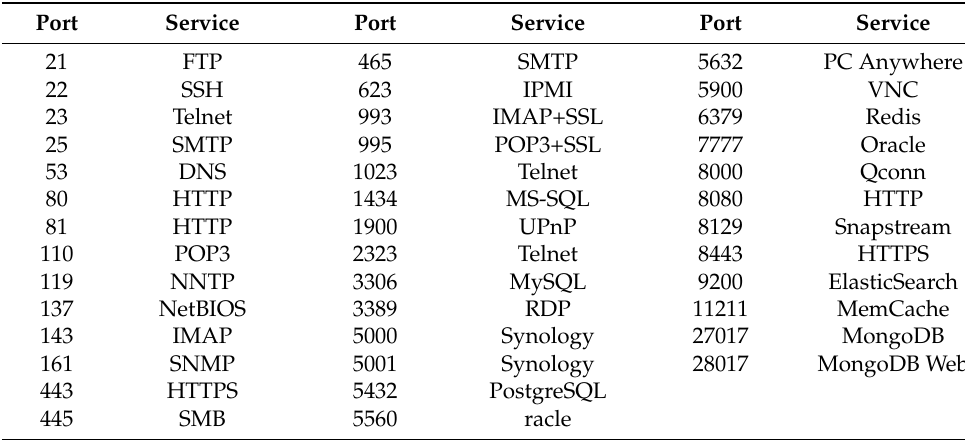
Table 1. Shodan documented service interrogation